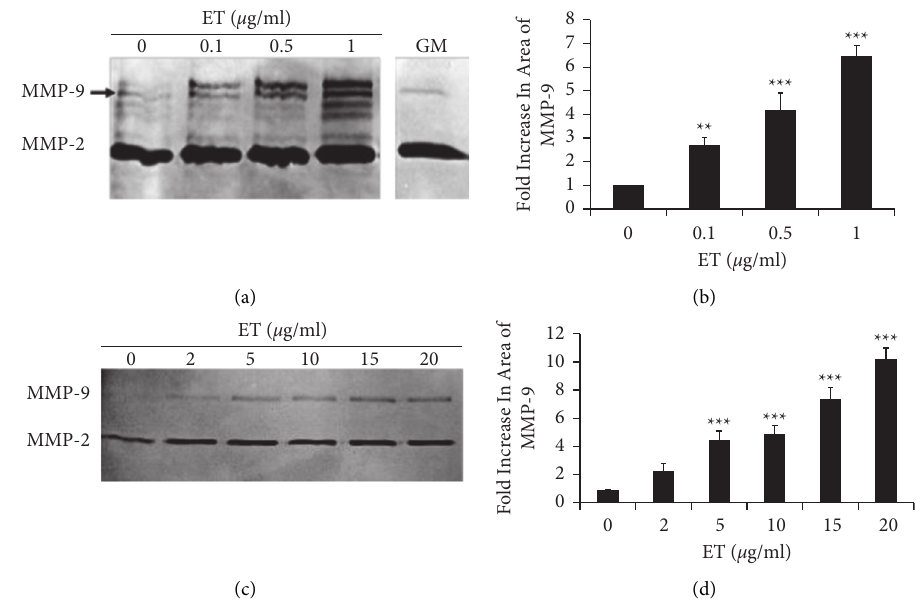
Figure 1: Short-term treatment with endotoxin induces MMP-9 activity in normal mouse (SCp2) and human (S1) mammary epithelial cells. Gelatin zymography of (a) SCp2 and (c) S1 conditioned media collected from untreated control cells (0 µ g/ml) and ET-treated cells (0.1, 0.5, and 1 µ g/ml for SCp2 cells; 2, 5, 10, 15, and 20 µ g/ml for S1 cells) upon reaching 75% confluence after treatment showed dose-dependent upregulation of MMP-9 activity. No differences in the growth profile of ET-treated cells were noted, and all cultures reached 75–80% confluence within the same time frame. The abundant MMP-2 levels noted in the conditioned media of a SCp2 are comparable to basal levels in growth medium (GM). (b, d) Bar graphs represent the quantification of fold increase in peak area of MMP-9 bands shown in the respective zymograms. Each bar represents triplicate analyses of mean ± SD; ∗∗∗ P < 0 . 001 compared to the untreated